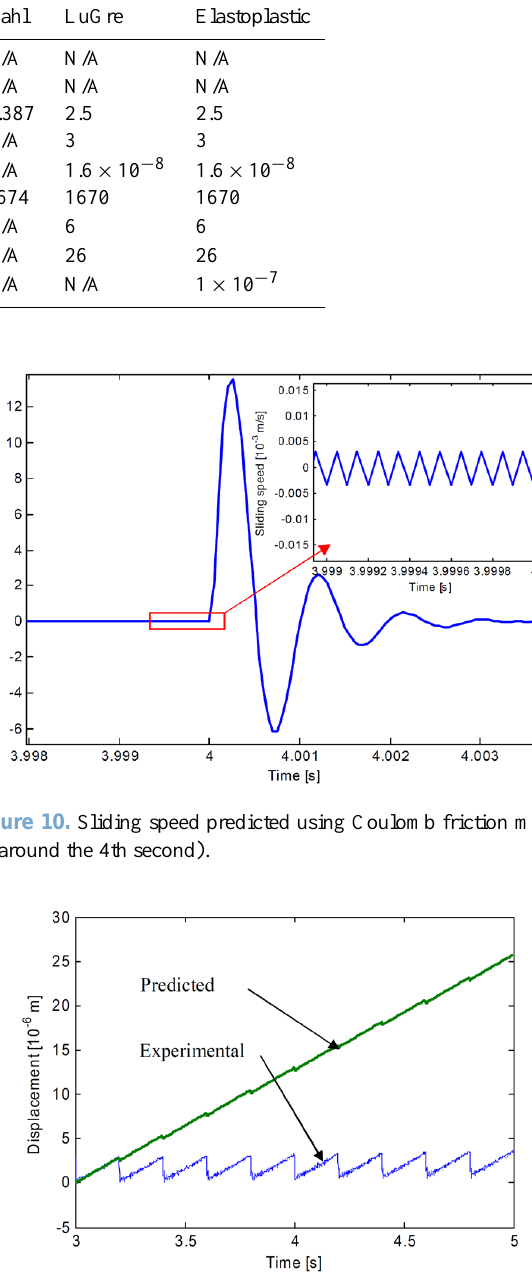
Figure 11. Displacement predicted by Coulomb model ( µ =